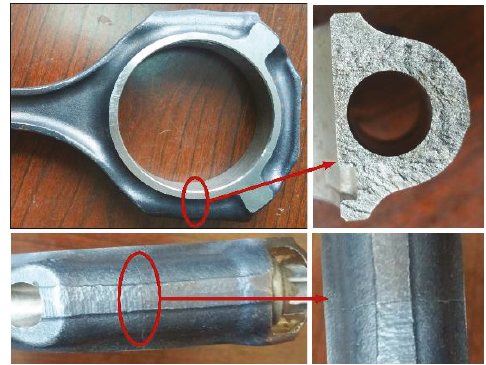
Figure 13. Experimental results of connecting rod fracture-split.